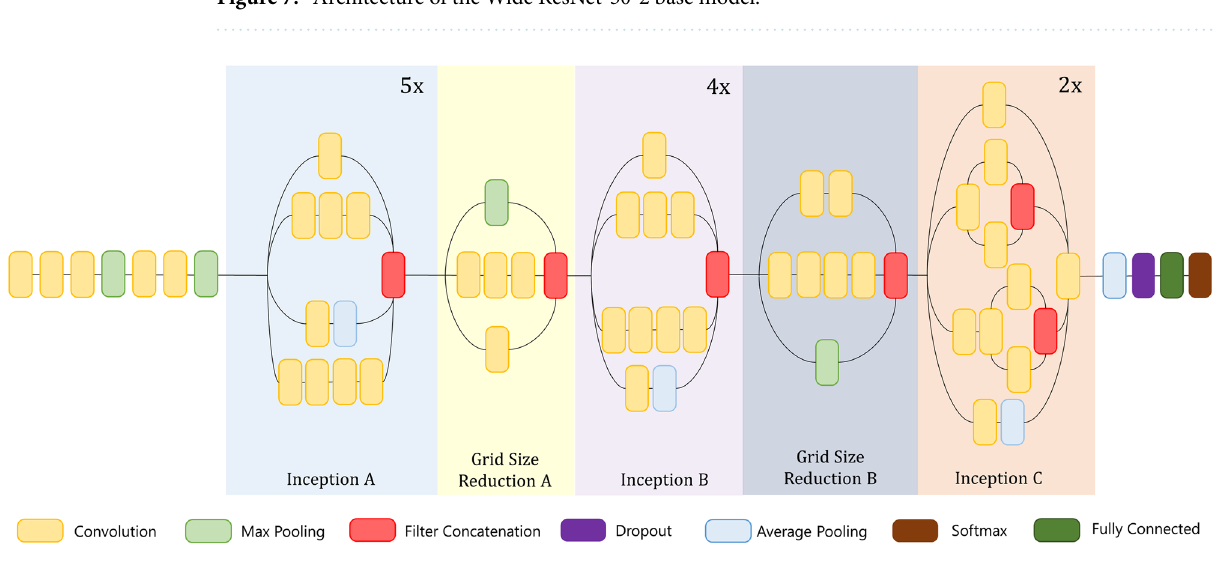
Figure 8. Architecture of the Inception V3 base